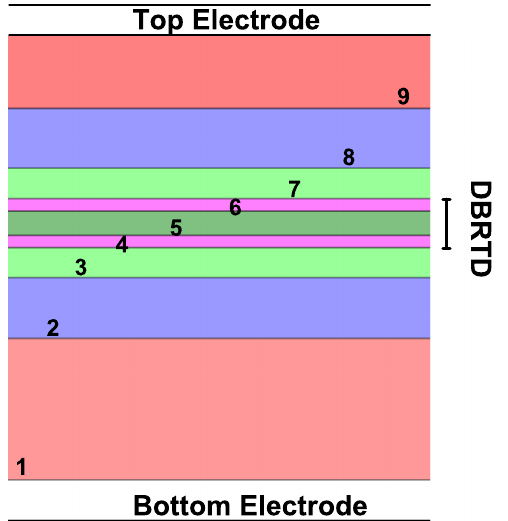
Figure 10. RTD structure composed of 9 layers that are expanded in detail in Table 3. DBRTD stands for Double-Barrier Resonant Tunneling